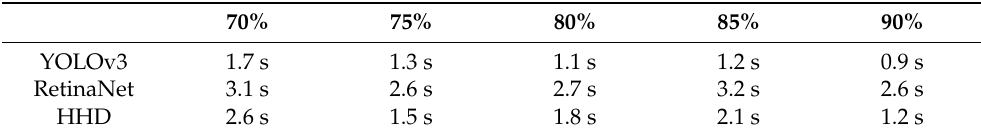
Table 2. Average detection speeds for YOLO, RetinaNet, and hybrid human detection for varying smoke concentrations.